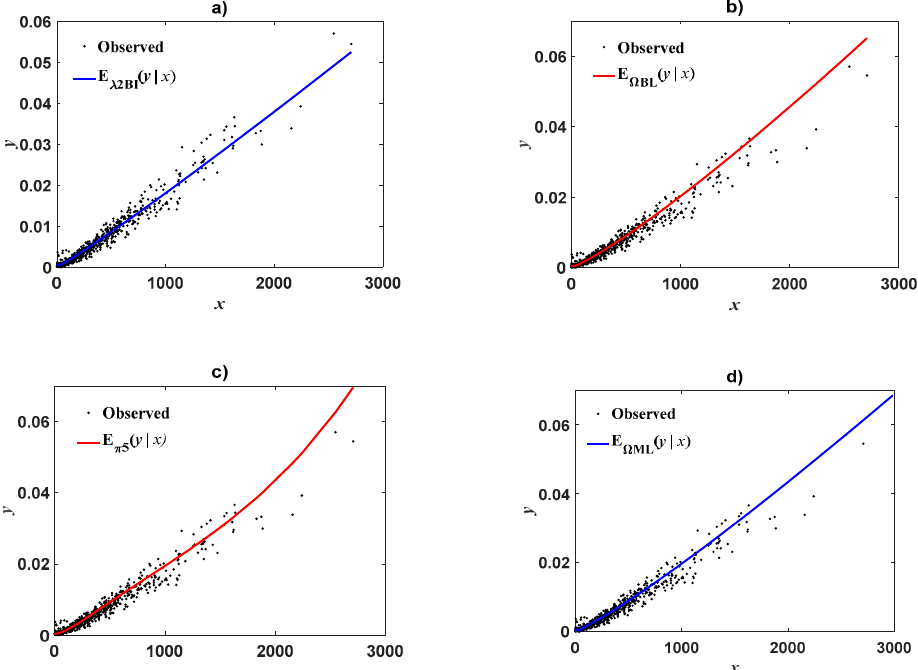
(cid:12) (cid:12) (cid:12) x ) produced (cid:12) (cid:12) (cid:12) x ) deriving from